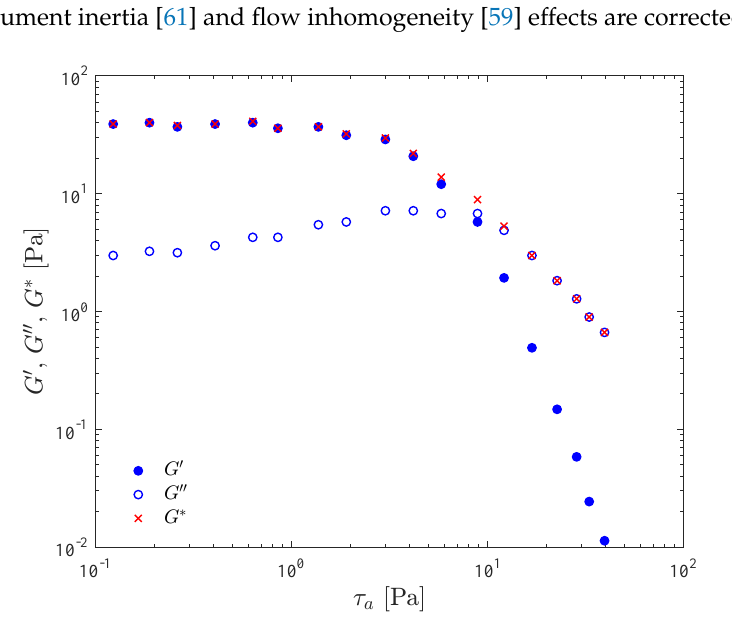
Figure 1. Stress amplitude sweep test results for a 0.123wt% Carbopol aqueous